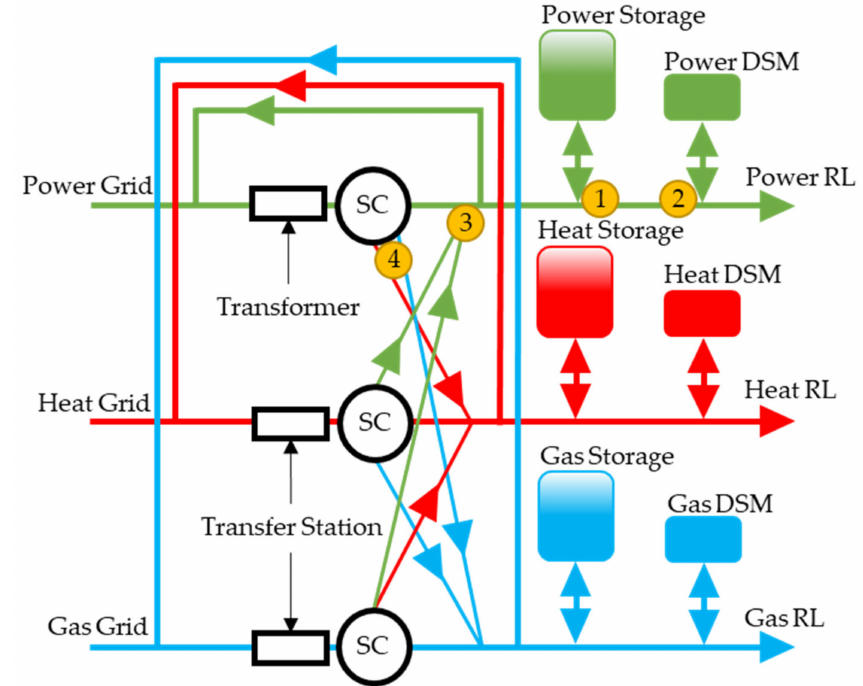
Figure 6. Generic node optimization representation.